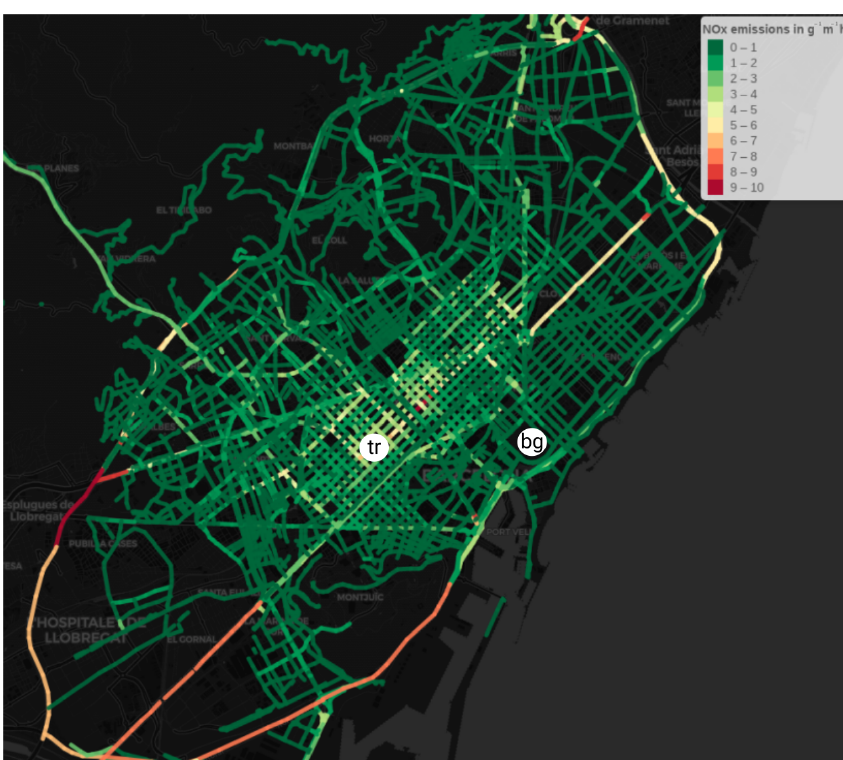
Figure 2. NO x emissions in grammes per metre per hour in Barcelona city at 07:00UTC on 11 April 2013 and location of the two fixed monitoring stations used to estimate the NO 2 / NO x ratio. White circles with letters inside represent the stations: tr is Eixample traffic station and bg is Ciutadella Park urban background